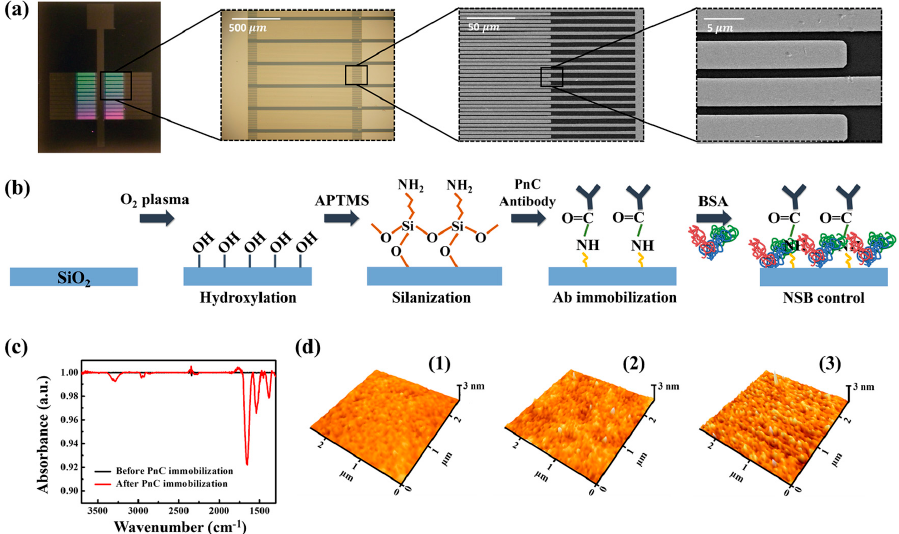
Figure 2. ( a ) The images of an integrated gap device having 24 microgap devices. Zoomed-in images show detailed structure of IDE device. ( b ) Chemical process for the functionalization of silicon oxide surface. ( c ) ATR-IR spectrum before and after the PnC immobilization. ( d ) AFM images of the silicon oxide region of the microgap device: ( d1 ) Before silanzation; ( d2 ) after silanization; ( d3 ) after immobilization of the PnC antibody.